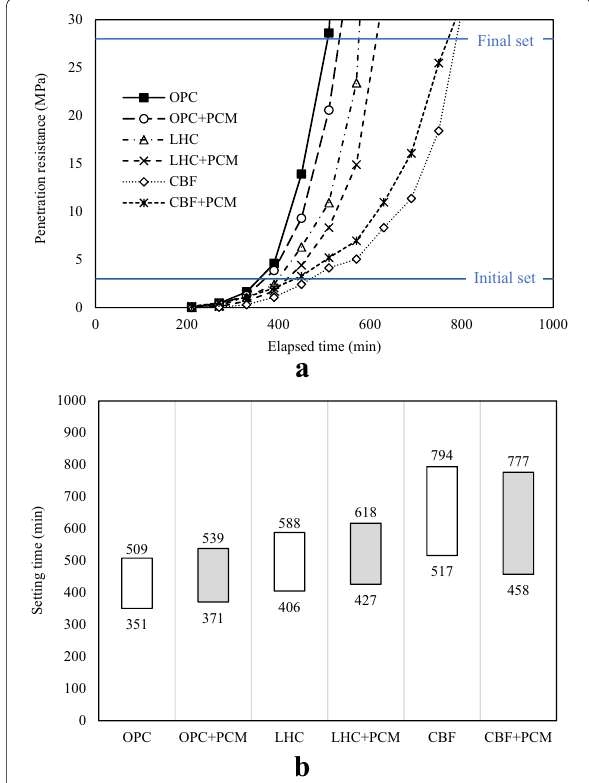
Fig. 3 Setting properties of concrete using PCM; a penetration resistance, b setting